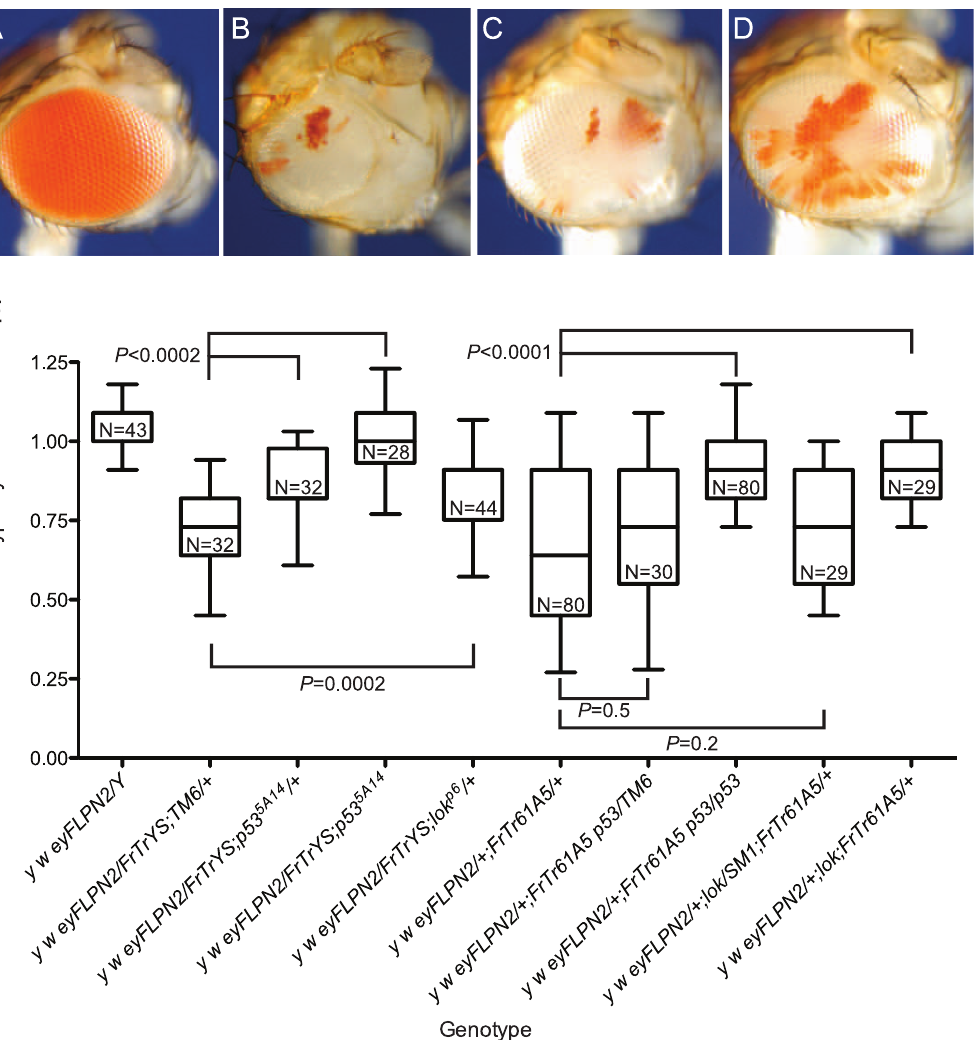
Figure 5. Cell survival after telomere loss from B + Y or chromosome 3 . Representative eyes are pictured: (A) y w/DcY(FrTrYS)4B1A ; (B) y w {eyFLP.N}2/DcY(FrTrYS)4B1A ; (C) y w {eyFLP.N}2/DcY(FrTrYS)4B1A; p53 5A-1-4/ + ; (D) y w {eyFLP.N}2/FrTrY;p53 5A-1-4 . White sectors in the eye positively mark cells that have lost a telomere. (E) Box-and-whisker plot showing DcY(FrTrYS)4B1A and Dc3(FrTr61A5) in p53 and lok mutant and wildtype backgrounds. The first whisker plot is a control and is repeated here (from Figure 2) for ease of comparison. All sizes are presented after normalization to wild type. Significance levels for critical comparisons are indicated.